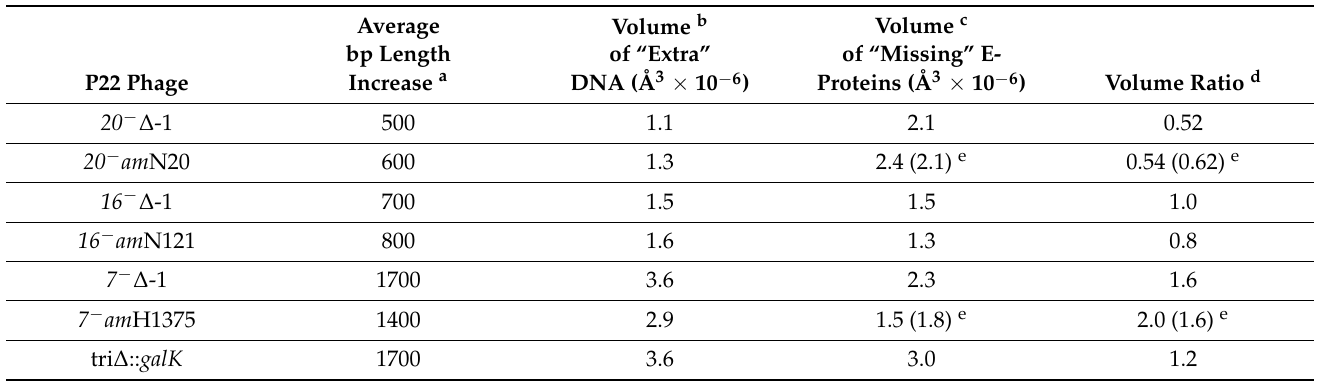
Table 3. Volumes of extra DNA and missing protein in E-protein mutant